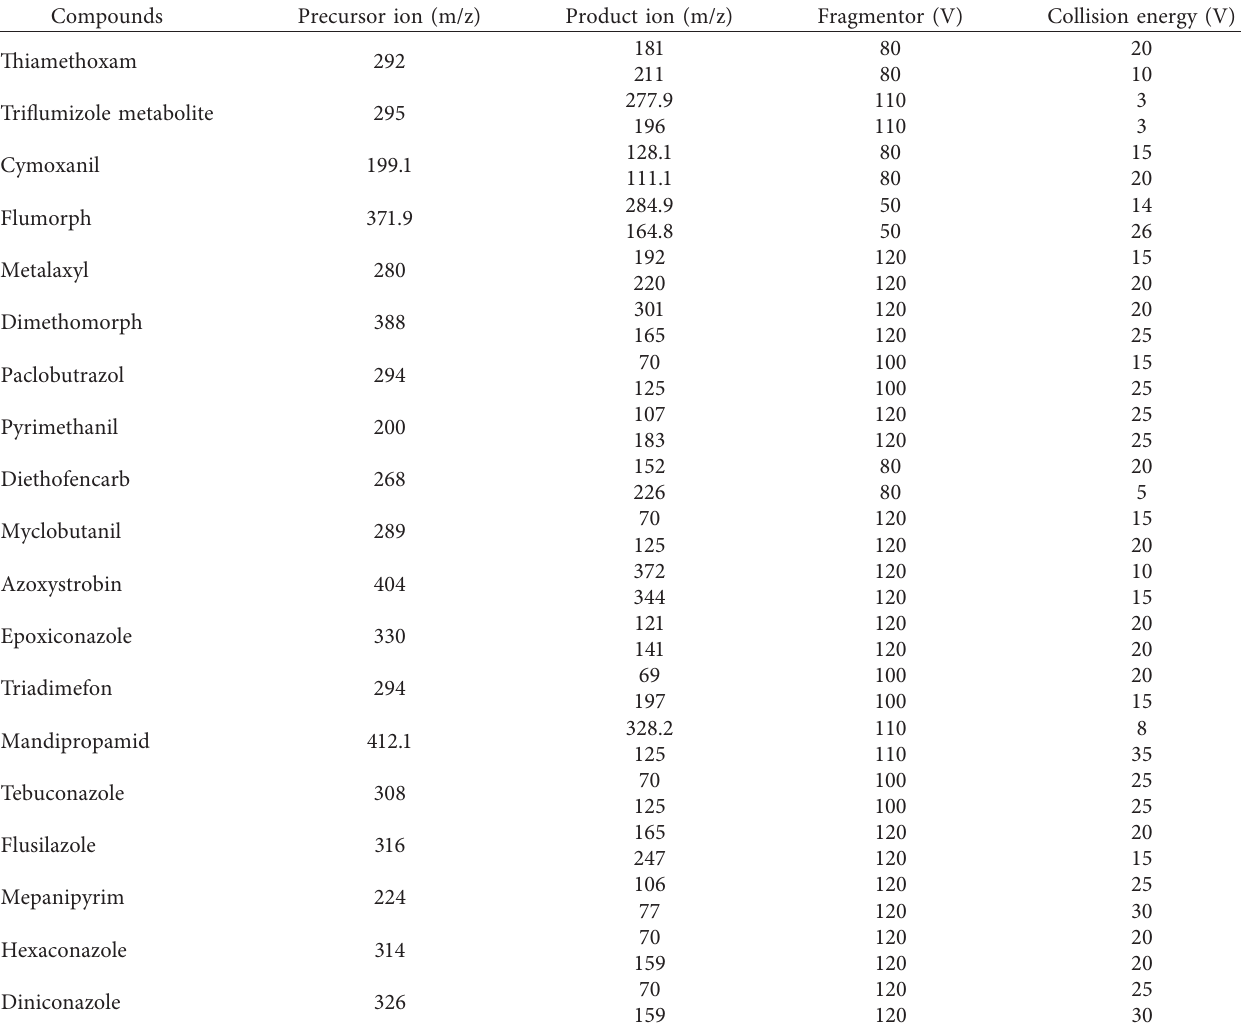
Table 1: Mass spectrometry conditions for 31 pesticides.